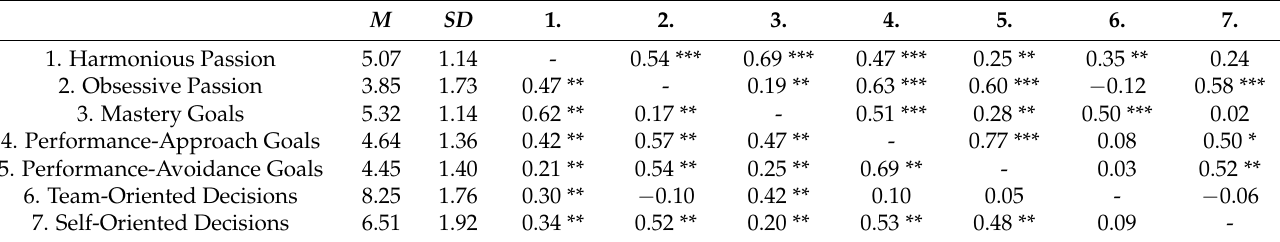
Table 1. Means, Standard Deviation, and Correlations among Model